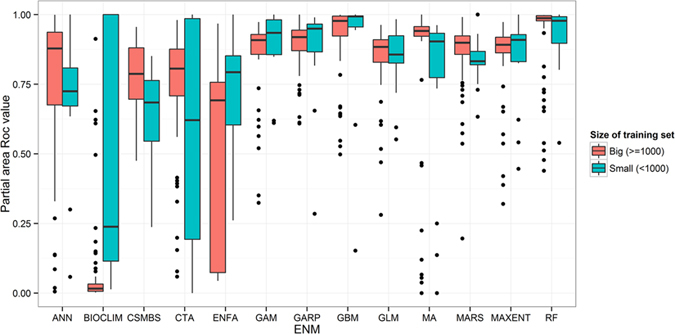
The partial-area ROC values of the 13 models utilizing different training set sizes, which are shown by the boxplots.The red boxplots are partial-area ROC values for the large training sets, and the green boxplots represent the small training sets.